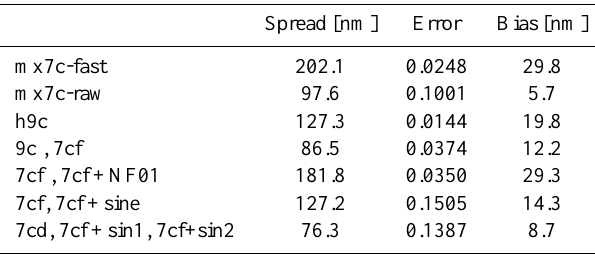
Table 5. Average spread, error, and bias over the wavelength range 450–650nm for different cameras and filter